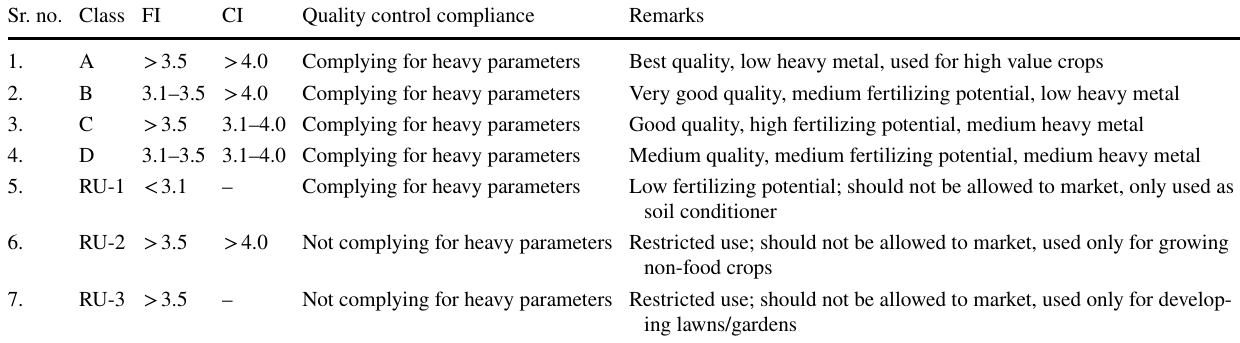
Table 7 Classification of MSW compost for their marketability and use in different area (Mandal et al. 2014)